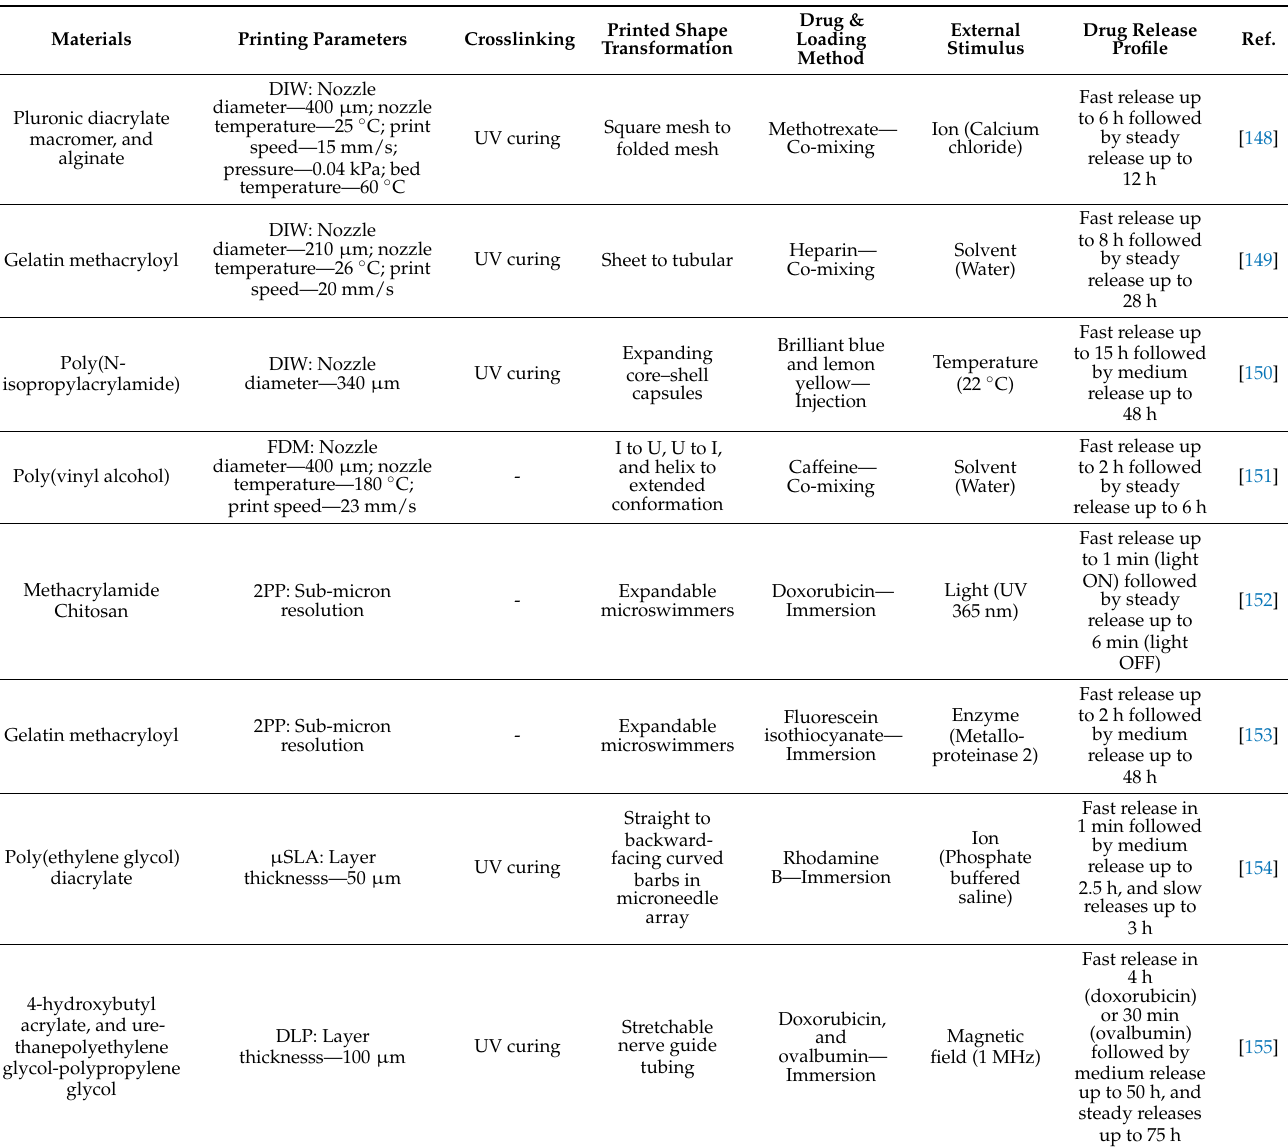
Table 2. Summary of emerging 4D printed hydrogels for drug delivery